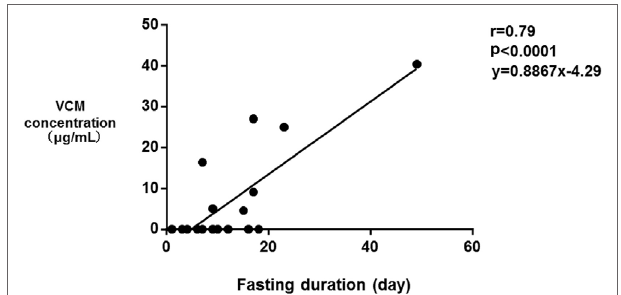
FigUre 3 | Correlation between the serum vancomycin (VCM) concentrations and the fasting duration. Each plot depicts a relationship between the duration of fasting (day) on the x -axis and the serum VCM concentration (microgram per milliliter) on the y -axis. There was also a significant correlation between the serum VCM concentrations and the fasting duration ( r = 0.79, p <